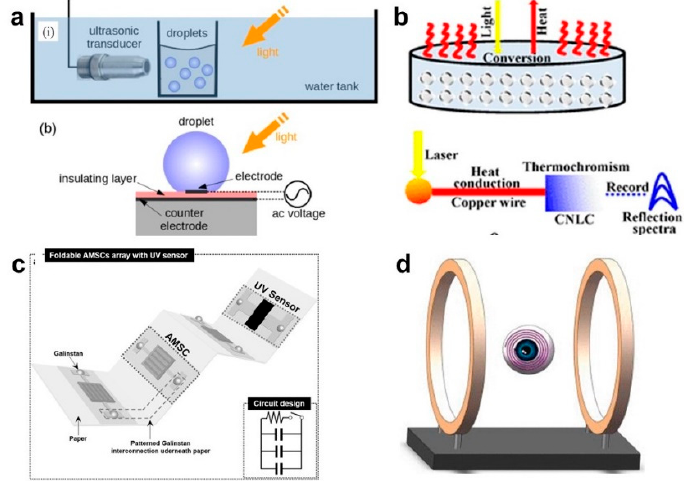
Figure 10. Liquid metal–based optical sensors. ( a ) Schematic illustration of experimental setups for the excitation of capillary oscillation of nanodroplets with ultrasound (top) and AC voltage (bottom) [110]. C opyright (2017) American Physical Society. ( b ) LM microspheres are used as a free-standing